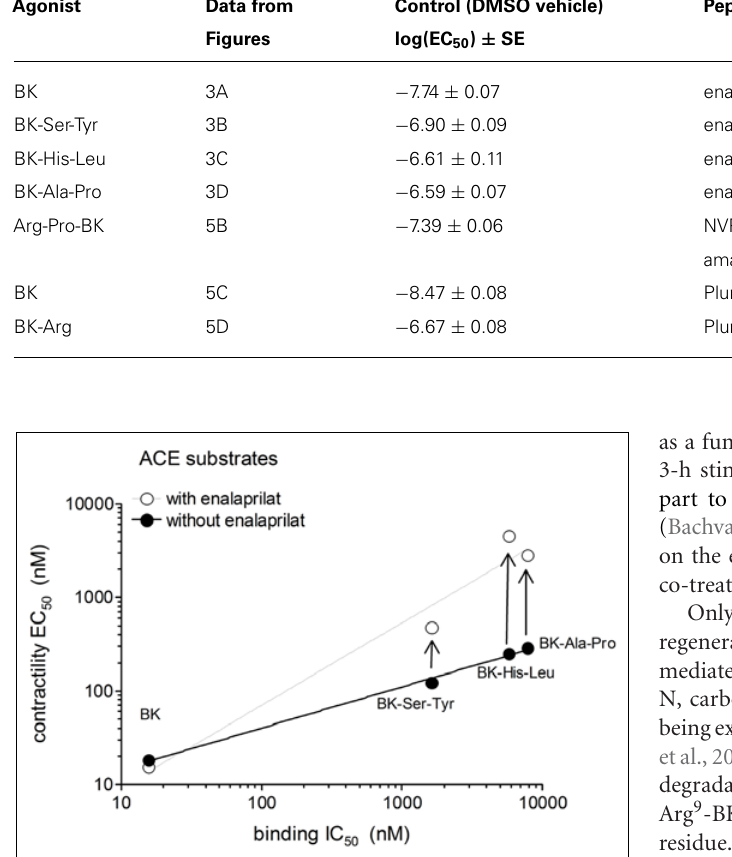
FIGURE 4 | Relationship between the IC 50 values obtained using the [ 3 H]BK binding competition assay and the contractility EC 50 values of BK analogs that have affinity forACE as a function of the presence of theACE inhibitor enalaprilat in the contractility